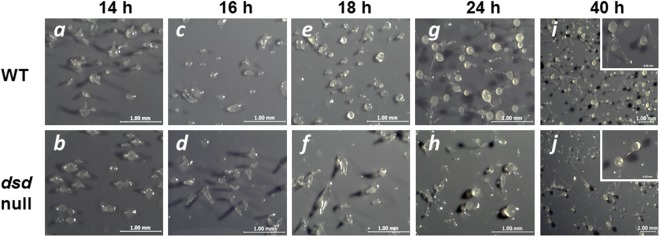
Developmental phenotypes of dsd-null mutant. WT (Top) and dsd-null cells (Bottom) were developed on the filter membrane at a density of 5.0 × 107 cells/cm2. The dsd-null cells exhibited aggregation delay and impaired spore formation efficiency compare to WT. Photographs of fruiting body were shown in the inset. Bars indicate 1 mm and 0.5 mm (inset). Experiments were conducted at least twice, and more than three times.